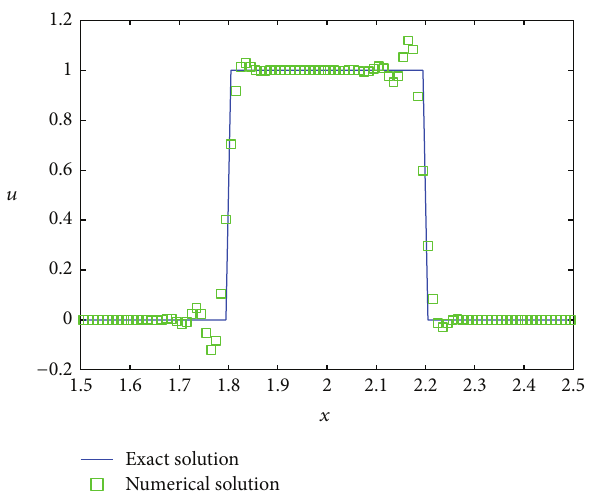
Figure 4: SHA method with TVD (27a) applied to linear advection equation for a square wave; numerical (symbols) and exact (line) solutions are compared at 𝑡 = 2